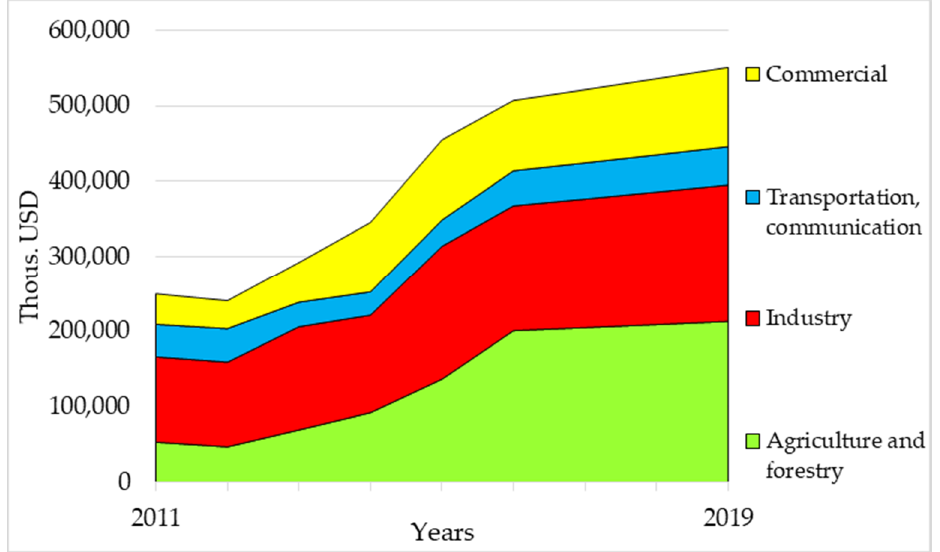
Figure 7. Historical data for Value added (GDP) in Isla de la Juventud (2011–2019) Source: own elaboration with the model [27].